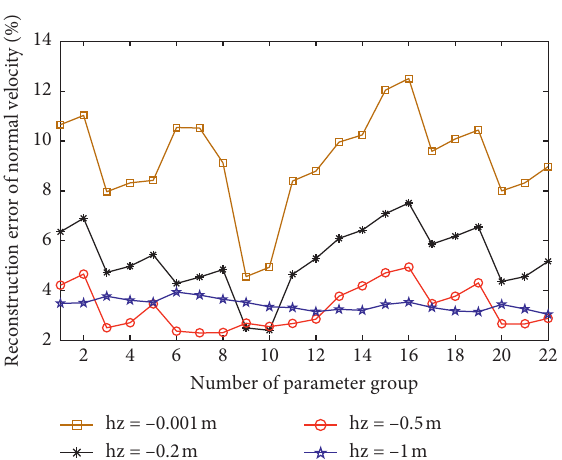
Figure 2: The reconstruction errors of normal velocity at 500Hz when using different CRP